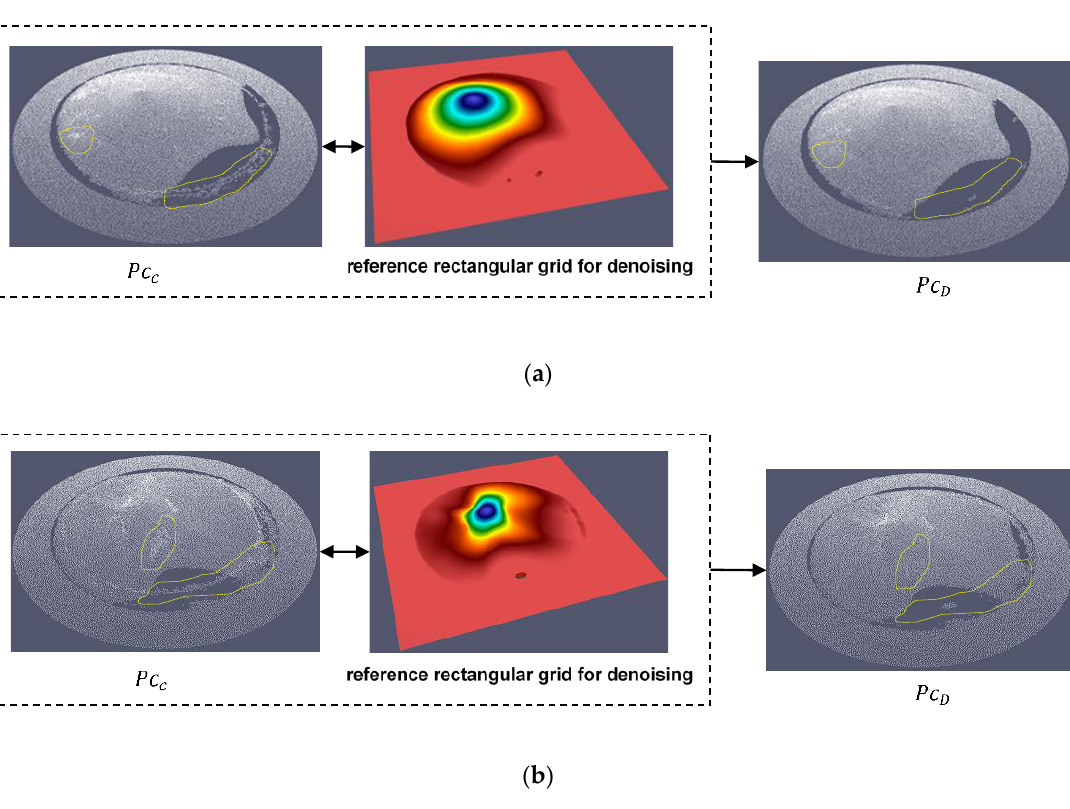
Figure 19. Denoising step by using the reference rectangular grid for denoising . Two yellow delimited zones are shown in 𝑃𝑐 𝐶 (before denoising) and 𝑃𝑐 𝐷 (after denoising): ( a ) point cloud corresponding to Patient 002; ( b ) point cloud corresponding to Patient 004.